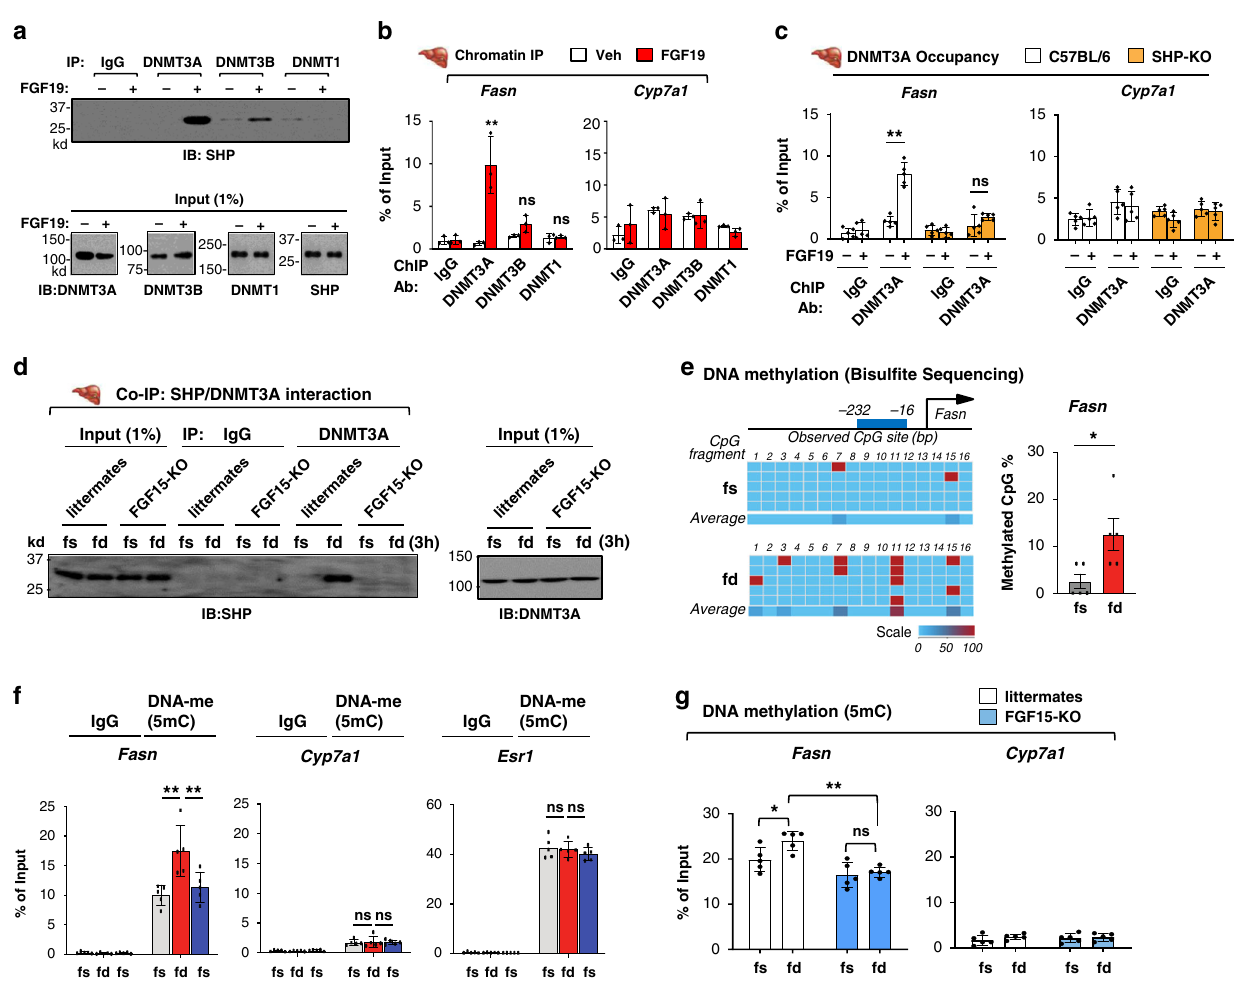
Fig. 3 Increased DNMT3A occupancy and DNA methylation at the Fasn promoter in the late fed state are dependent on both SHP and FGF15/19. a – c Mice were treated with vehicle or FGF19 for 2 h after fasting overnight. a Interaction of SHP with DNMTs in liver extracts determined by CoIP. b Occupancy of DNMTs at Fasn and Cyp7a1 determined by ChIP. c Occupancy of DNMT3A at the Fasn and Cyp7a1 determined by ChIP in SHP-KO or C57BL/6 mice. d FGF15-KO mice or littermates were fed normal chow for 3 h (fd) after fasting overnight (fs). Interaction of DNMT3A and SHP in liver extracts determined by CoIP (left). Input SHP in the liver determined by IB of 1% of the liver extract used for the CoIP assays (right). Tissues from 3 mice were pooled for each sample and the experiment was done twice. e – f C57BL/6 mice were fed normal chow for 3 h (fd) after fasting overnight (fs) and in ( f ) were fasted again overnight. e DNA methylation at speci fi c sites of Fasn promoter determined by bisul fi te sequencing. f DNA methylation at the Fasn, Cyp7a1, and Esr1 promoters determined by MeDIP. g FGF15-KO mice or littermates were fed normal chow for 3 h (fd) after fasting overnight (fs). DNA methylation at Fasn and Cyp7a1 determined by MeDIP. b , c , e , f , g Mean values ± SD are plotted ( b , n = 3 mice; c , e , f , g , n = 5 mice). Statistical signi fi cance was determined by ( b , c , f , g ) two-way ANOVA with Tukey post-test or ( e ) two-tailed Student ’ s t test. * P < 0.05, ** P < 0.01, ns, statistically not signi fi methylation at the Fasn promoter detected by bisul fi te sequencing the functional signi fi cance of hepatic DNMT3A in epigenetic (Fig. 3e) or by MeDIP (Fig. 3f, left). The increase in CpG repression of lipogenesis by FGF15-SHP, DNMT3A was down- methylation at Fasn after refeeding returned to the basal levels after regulated by AAV8-mediated expression of shRNA (Fig. 4a). fasting (Fig. 3f, left), suggesting that reversible DNA methylation DNMT3A protein levels were downregulated speci fi cally in the occurs at the Fasn promoter during a full fasting/feeding/fasting liver, but not in intestine or adipose tissue (Fig. 4b). Expression of cycle. In contrast, DNA methylation at Cyp7a1 was not detected nearly all of the lipogenic genes tested, was increased after (Fig. 3f, center) and DNA methylation at a highly methylated gene, downregulation of DNMT3A, while that of Cyp7a1 was not Esr1 41 , was not changed (Fig. 3f, right). Further, feeding-mediated (Fig. 4c). increases in DNA methylation at Fasn was not detected in FGF15- FGF19 treatment increased DNA methylation at the Fasn KO mice (Fig. 3g). These results indicate that increased levels of promoter (Fig. 4d) and decreased pre-mRNA and mRNA levels of FGF15 in the late fed state induces the SHP interaction with Fasn (Fig. 4e, f), and these FGF19-mediated effects were DNMT3A and increases DNA methylation at the Fasn promoter, diminished in DNMT3A-downregulated mice (Fig. 4d – f). Con- which is associated with gene repression. sistent with these results, downregulation of hepatic DNMT3A markedly increased basal de novo lipogenesis (Fig. 4g) and hepatic TG levels (Fig. 4h) and signi fi cant inhibition of lipogenesis and TG levels by FGF19 was not observed after downregulation of DNMT3A. These results indicate that FGF19-